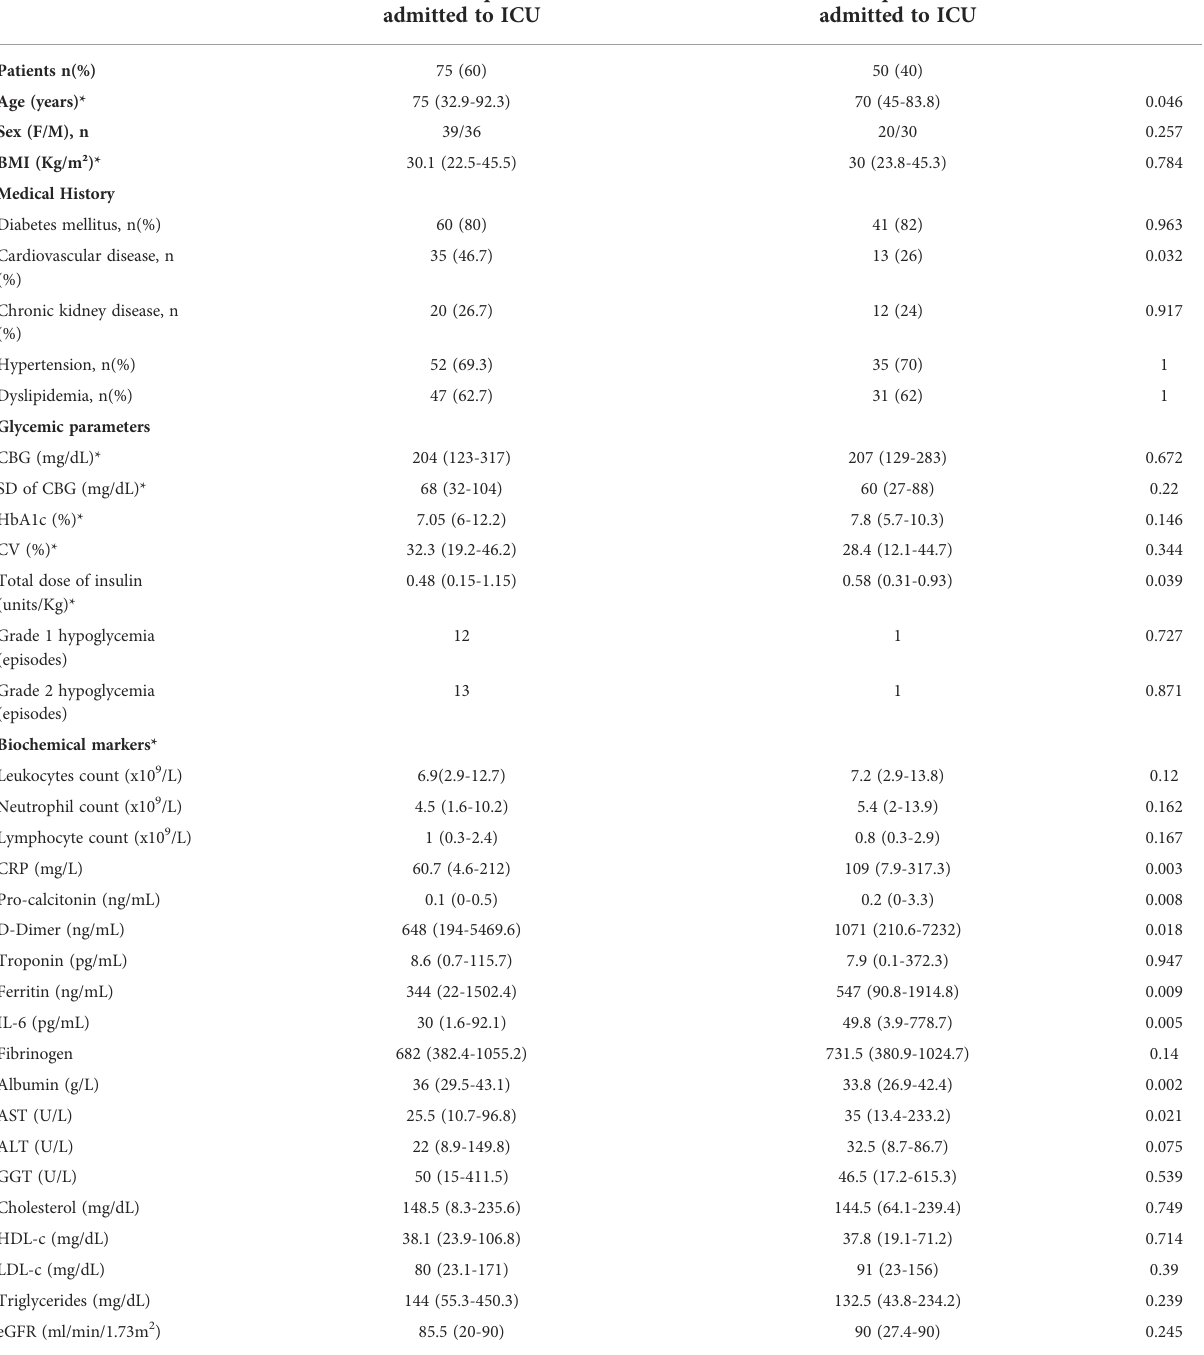
TABLE 2 Baseline clinical characteristics and glycemic parameters in patients with diabetes mellitus related to IMV requirement or admission to ICU. Patients who did not require IMV nor were Patients who required IMV or admitted to ICU